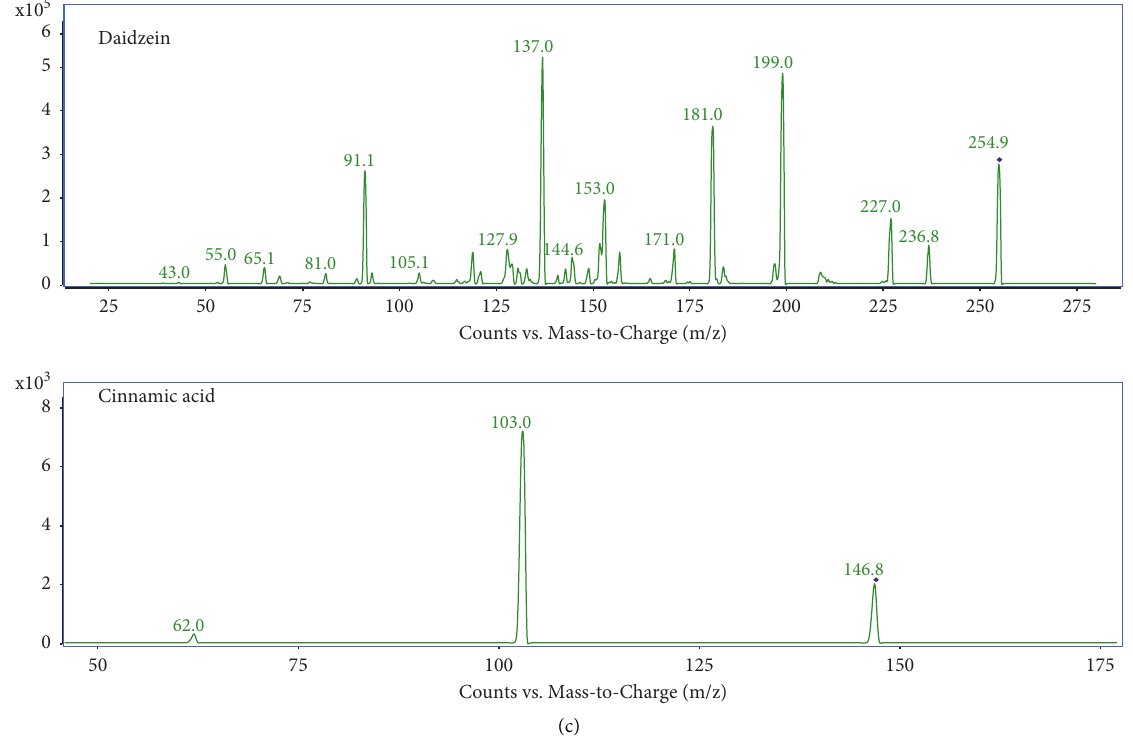
Figure 3: Product ion mass spectra of [M+ H]+ ions of puerarin, daidzin, coptisine, epiberberine, jatrorrhizine, berberine, palmatine, coumarin, and daidzein; [M-H]- ions of cinnamic